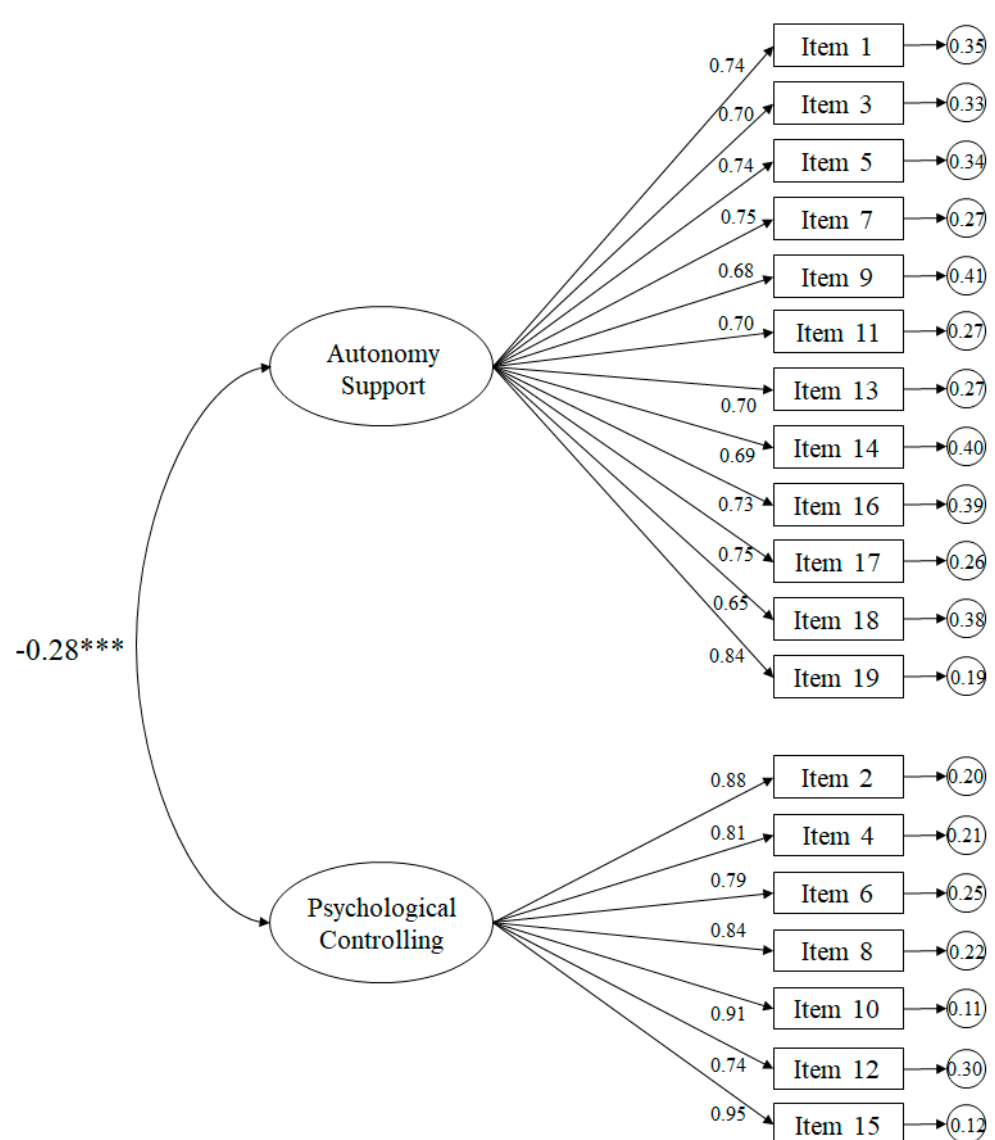
Figure 2. Confirmatory factor analysis of the SPSEC-P. The ellipses represent the factors and the rectangles represent the various items. Residual variances are shown in the small circles. The fit indices of the tested model related to friends (Figure 3) revealed appropriate fits: χ 2 (151. N = 428) = 552.45, p < 0.001; χ 2 / df = 3.66; CFI = 0.96; IFI = 0.96; RMSEA = 0.074 (IC 90% = 0.073–0.084); SRMR = 0.040. The standardized regression weights ranged from 0.67 to 0.96 and were statistically significant ( p < 0.001). The correlation between the support for autonomy and the psychological control factors was − 0.53 and was likewise statistically significant ( p <